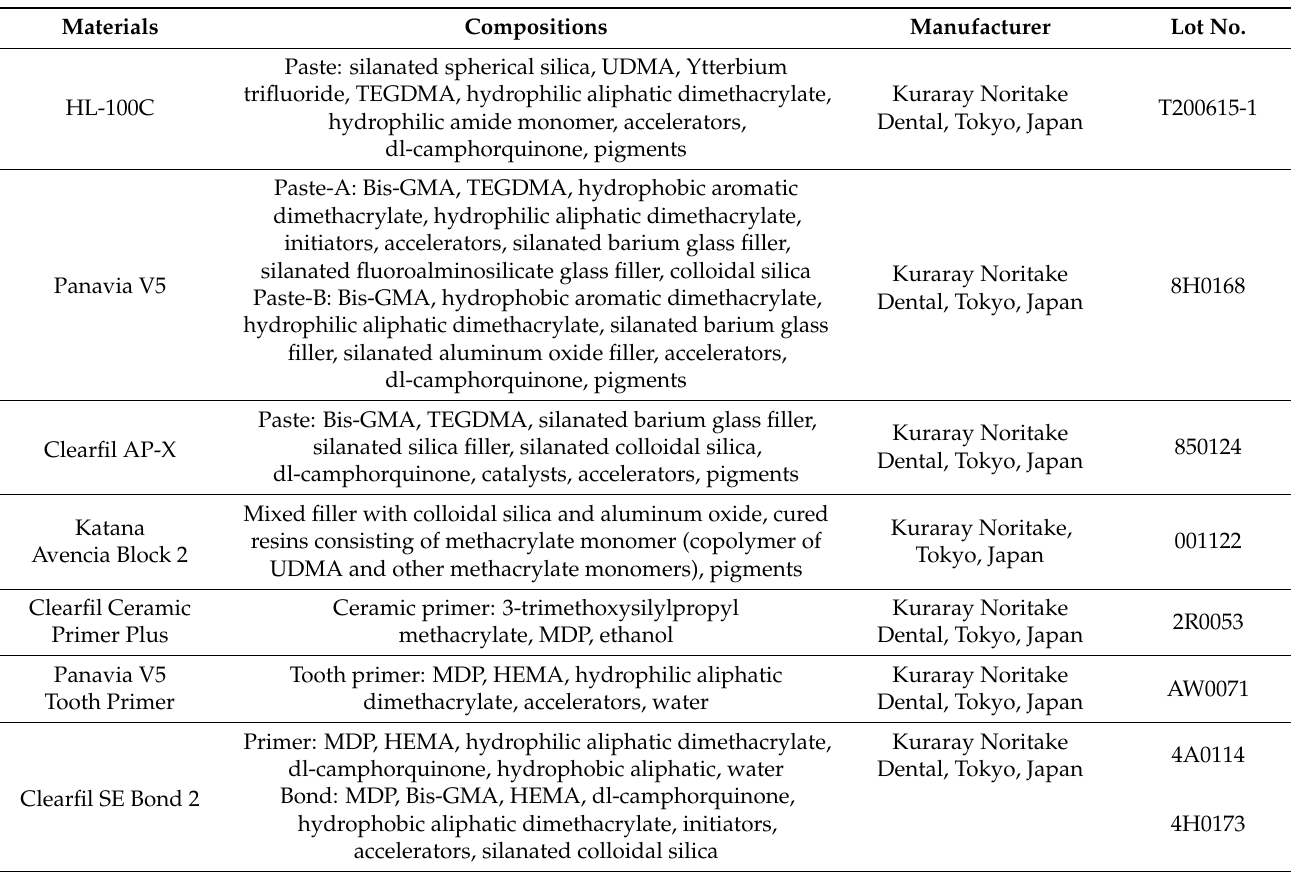
Table 1. Composition of the tested materials.